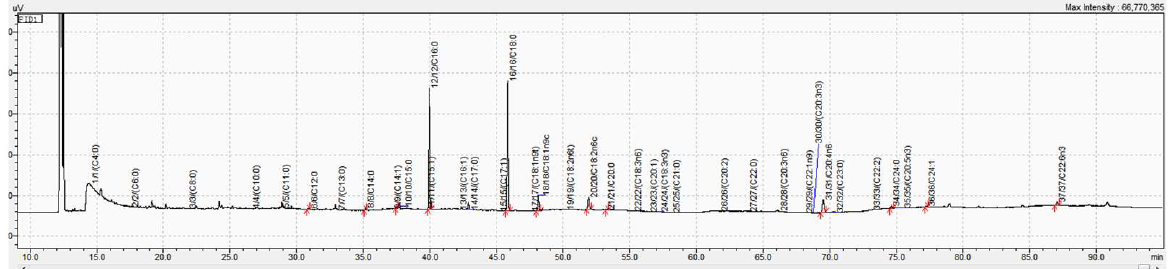
Figure 2. Human erythrocyte membrane fatty acid standard spectrum.